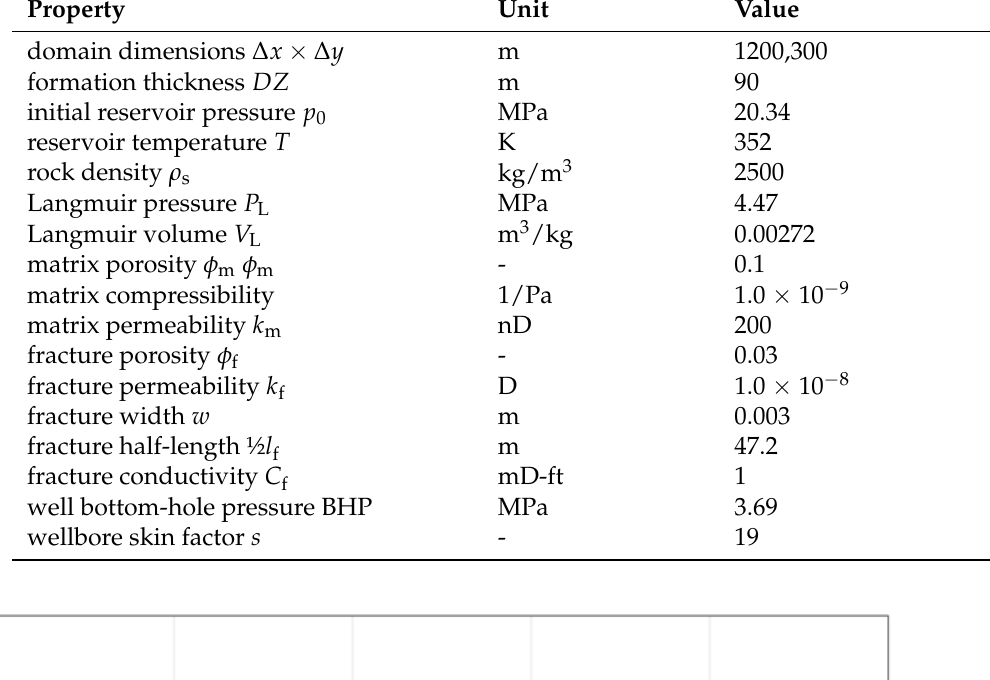
Table 5. Input data for Barnett shale reservoir simulation AE1 [60]; other input in Table 2.